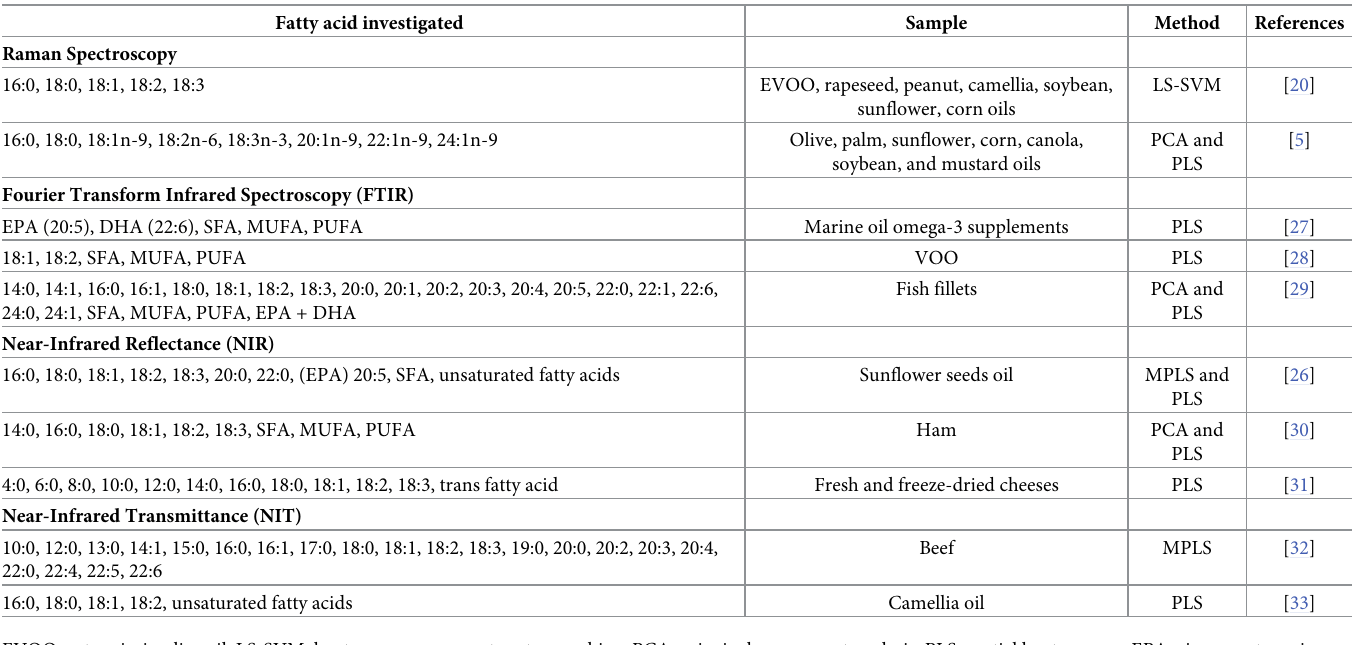
Table 1. Methods for the prediction of fatty acids. Fatty acid